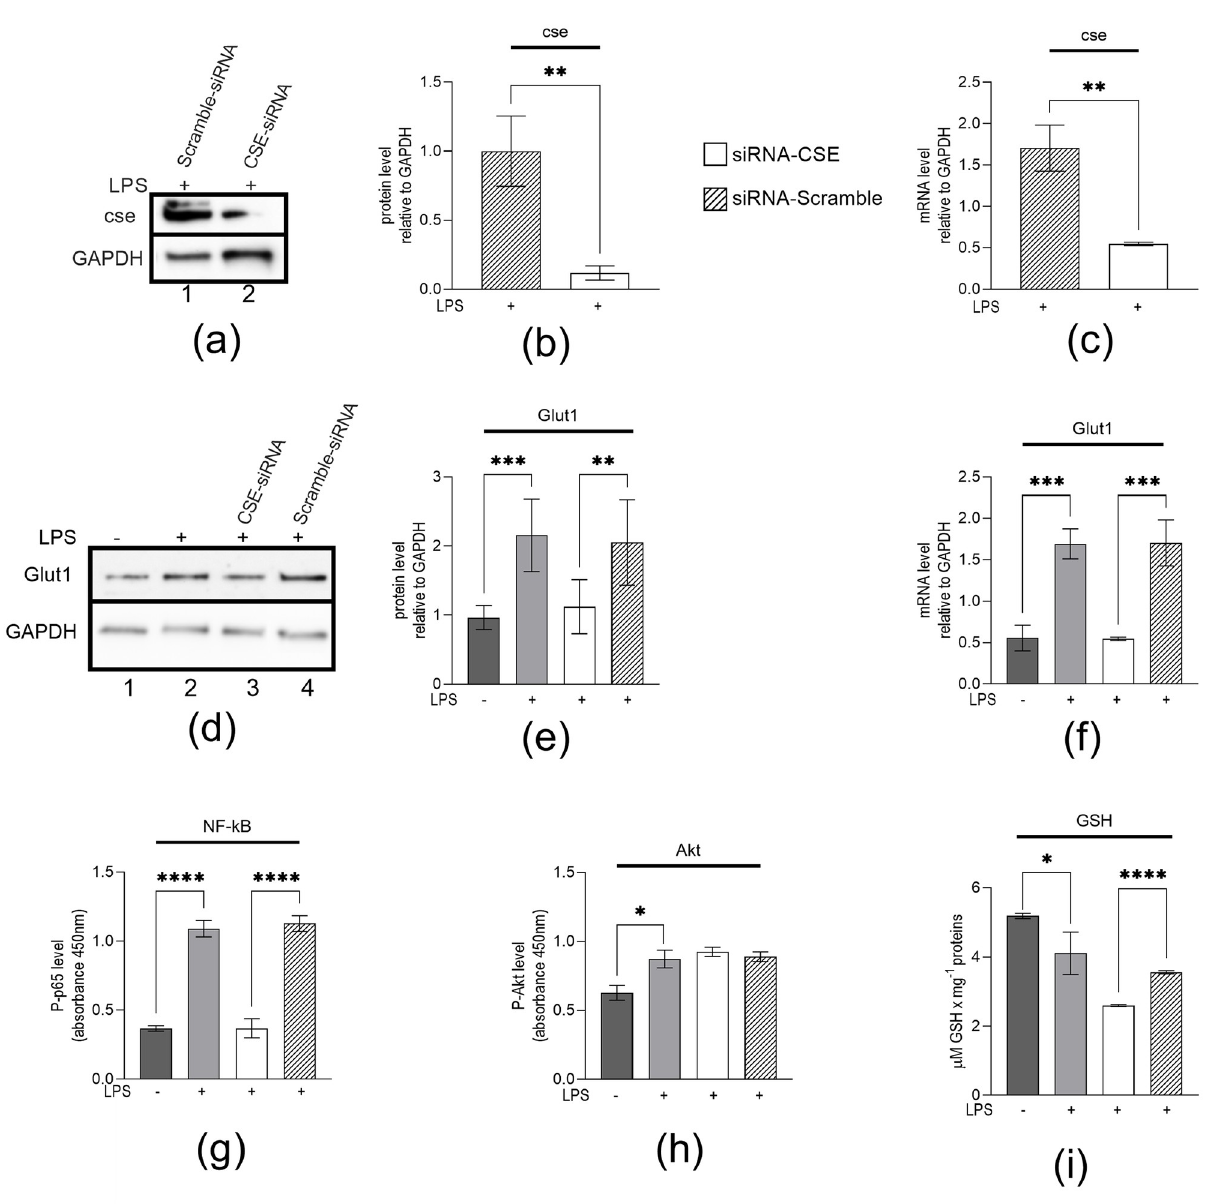
Fig 3. LPS stimulated macrophages genetically silenced of CSE gene to inhibit CSE expression, decreased NF- κ B activation (Phospho-p65), Glut1 expression, and glutathione (GSH) level. ( a – f ) RAW264.7 cells were transfected (24 h) with CSE-siRNA or Scramble-siRNA, followed by treatment with LPS. RAW264.7 cells were analyzed by Western blotting using antibodies against CSE, Glut1, and GAPDH (loading control) (panels a and d ). The changes in amounts of Glut1 have been quantified by ImageJ software and shown in panels ( b and e ). (Panel c and f ) RT-qPCR analyzed RNA for the expression of CSE and Glut1. GAPDH was used as a control. RAW 264.7 cells were analyzed by ELISA targeting Phospho-p65 (NF- κ B subunit) (panel g ) or Phospho-Ser473 (Akt subunit) (panel h ). GSH levels were determined by a fluorometric kit. Samples were mixed with reagent, and fluorescence intensity was monitored at EX/EM of 490/520 nm. GSH was calculated from the standard curve and reported as GSH � mg protein-1. Data represent mean ± SD (n = 3); � p < 0.05, �� p < 0.001, ��� p < 0.0001, ���� p < 0.00001. significantly (p = 0.086) upon treatment with 500 μ M GYY4137, without the addition of LPS. This expression of Glut1 is significantly reduced upon application of IKK-inhibitor, Bay11- 7042 (0.22 ± 0.05 vs. 0.82 ± 0.13; p = 0.0018), or PI3K inhibitor, LY294002 (0.31 ± 0.13 vs. 0.82 ± 0.13; p = 0.008) (Fig 4c). RT-qPCR analysis showed that LPS-induced Glut1 is decreased